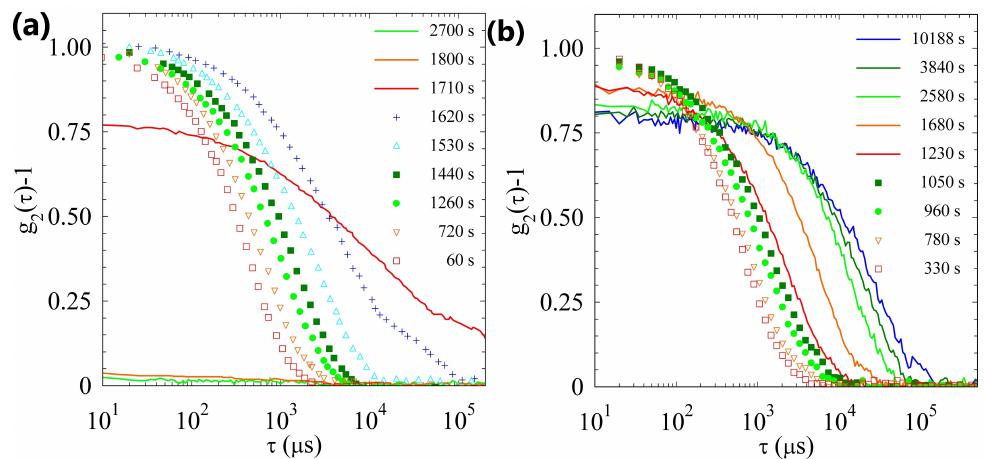
Figure 8. ( a ) ICFs at different times, indicated in the legend, for sample H seeded with PMMA nanoparticles. ( b ) ICFs at different times, indicated in the legend, for sample L seeded with PMMA nanoparticles. In both panels, symbols stand for ergodic samples, while continuous lines indicate ICFs taken after t g , when the time averaged ICF is no longer